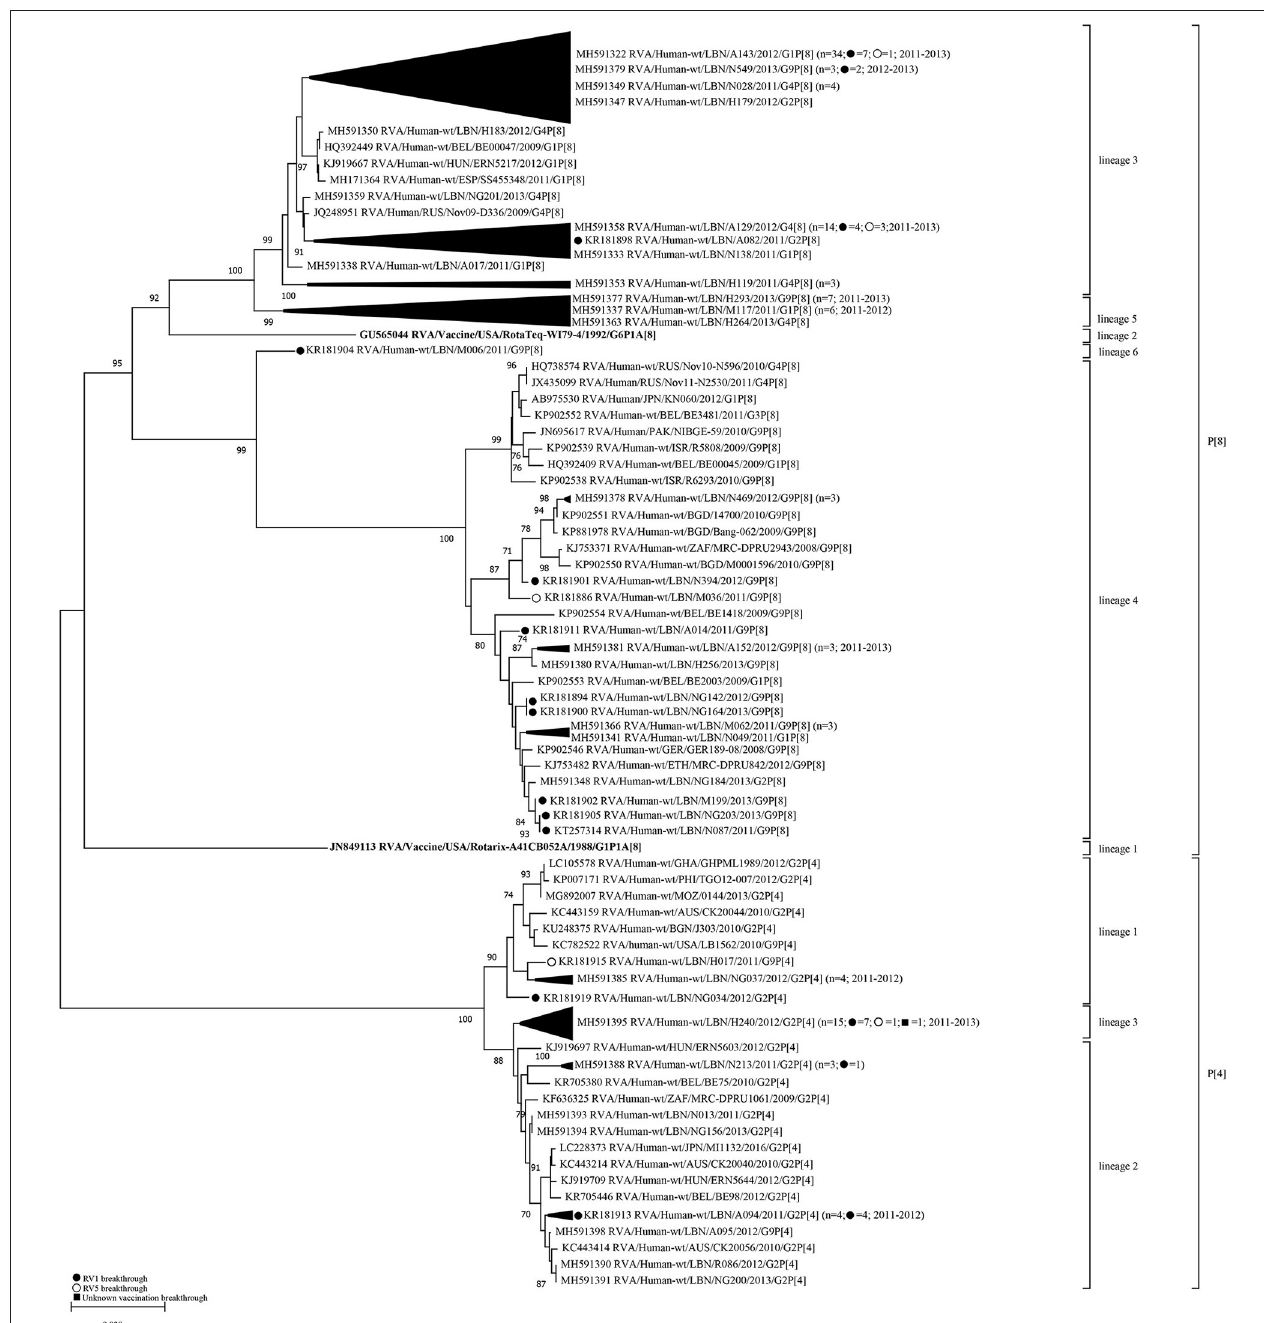
FIGURE 2 | Phylogenetic dendrogram of VP4 genes (reading frame 49-1422) of RVA strains circulating in Lebanon (2011-2013) in relationship globally representative strains and those of Rotarix ® and RotaTeq ® . Phylogenetic analysis was performed using the neighbor-joining method. All horizontal branch lengths are drawn to scale (nucleotide substitutions per base) and bootstrap values (1000 pseudo-replicates) are shown at branch nodes. The annotation indicates strain ID/genotype/year of isolation. Branches comprised solely of Lebanese strains were collapsed and one representative strain was indicated for each branch. The total number of specimens in each collapsed branch and the years of isolation are indicated in parenthesis. The number of breakthrough specimens for each collapsed branch is also shown. the VP7 surface ( Figure 3B ). Interestingly, two of the non- specimens acquired two additional changes compared to breakthrough G1 isolates (M117 and A017) showed changes G1 of RotaTeq R (cid:13) : D97E and S147N, occurring in the 7- with respect to the RotaTeq R (cid:13) - G1 strain but not that of 1a and 7-2 epitopes. Mapping of these variations onto the the Rotarix R (cid:13) VP7 trimer revealed that they tend to heterogeneously span